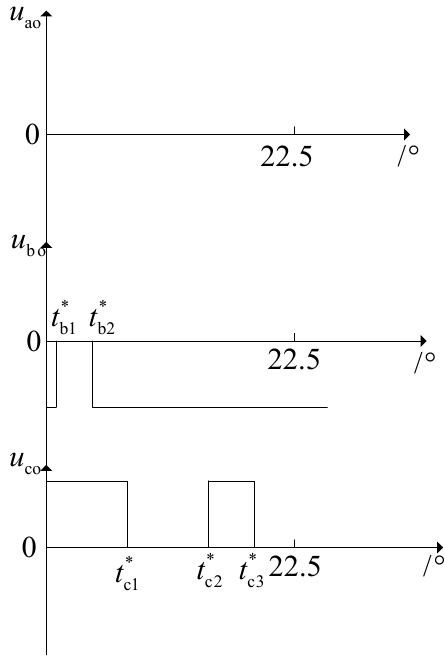
Figure 7. Principle of the calculation for N i .